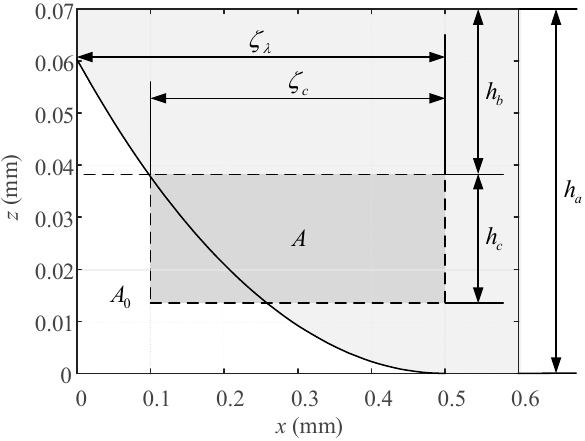
Figure 10. The Abbott–Firestone curve of the sealing surface.